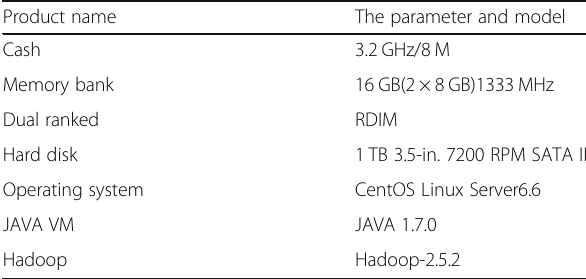
Table 1 Software and hardware